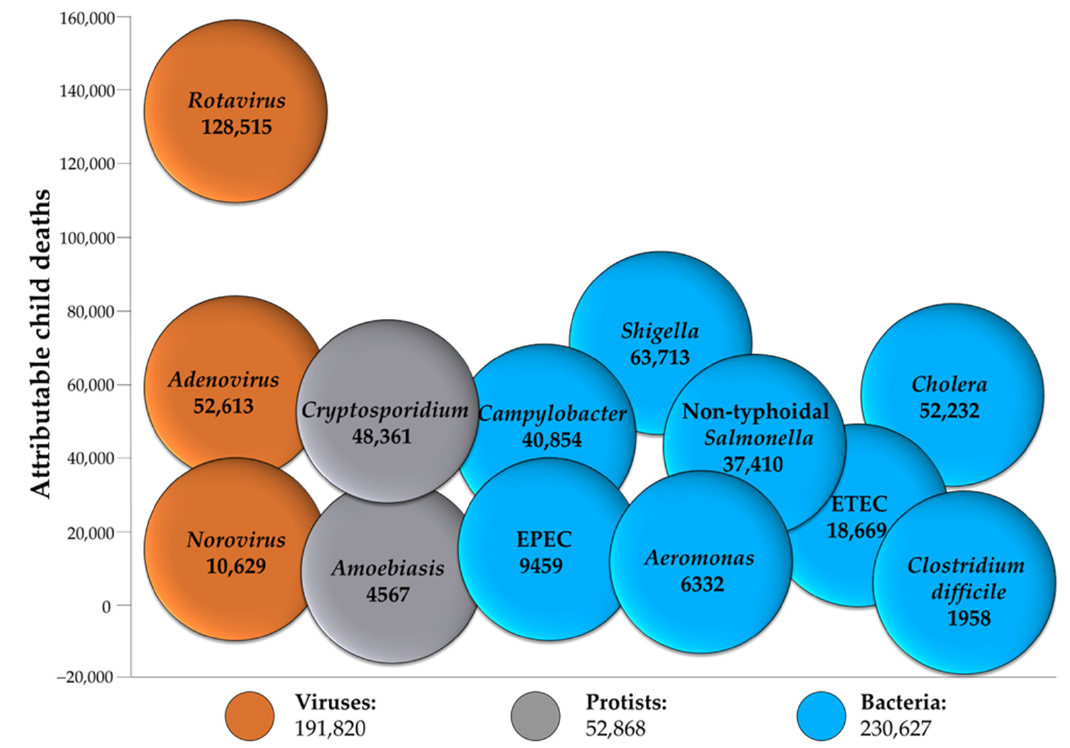
Figure 1. Major pathogens responsible for diarrhea in children under 5 years old. Each ball reports the number of deaths from diarrhea attributed to each pathogen in 2016 (data source: https://ourworldindata.org/diarrhoeal-diseases) (accessed on 23 January 2023). ETEC: